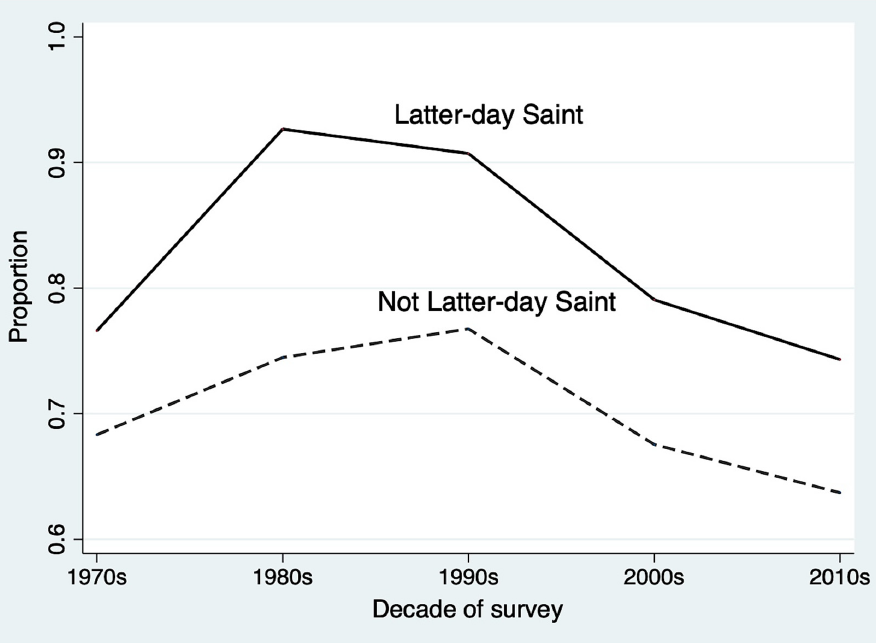
Figure 1. Proportion supporting the death penalty by decade of survey, General Social Surveys, 1974–2018.